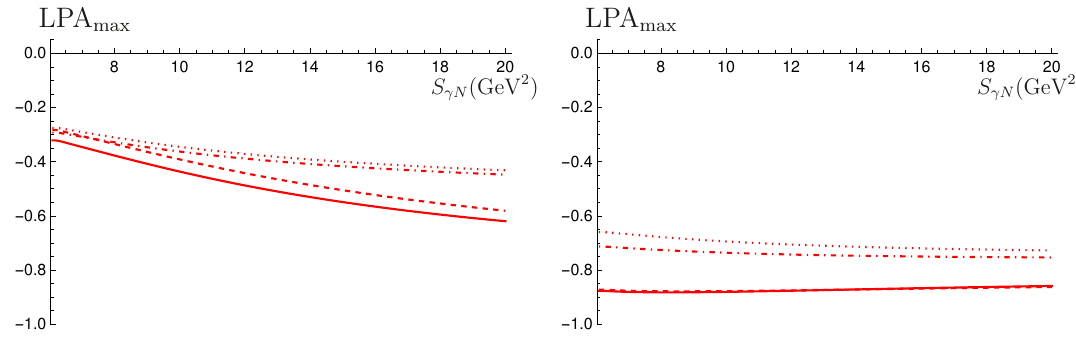
Figure 37 . The LPA at the single differential level for π + ( π − ) is shown as a function of M 2 the left (right). The brown, green and blue curves correspond to S (non-dashed) lines correspond to holographic (asymptotic) DA, while the dotted (non-dotted) lines correspond to the standard (valence) scenario. The same colour and line style conventions as in figure 6 are used here.